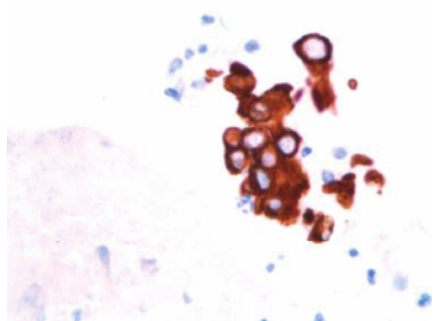
Figure 3: Intact tumor cells show delicate rims of amphophilic cytoplasm. Focal nuclear molding is seen (arrow) (Papanicolaou stain, ThinPrep, 1000x).